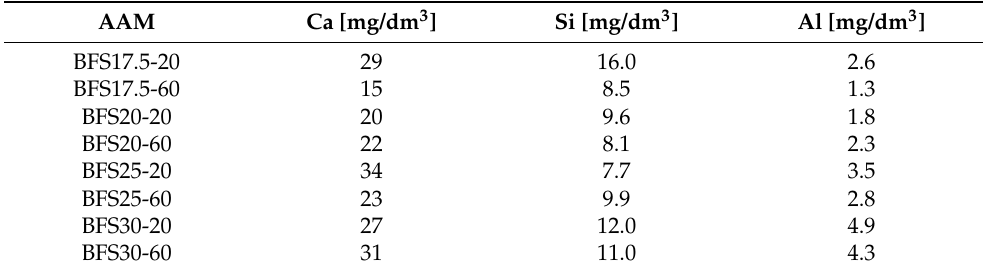
Table 2. Ca, Si, and Al concentrations of aqueous solutions after 4 h at 150 ◦ C, under an N 2 atmosphere of 2 MPa and an AAM concentration of 4 g/dm 3